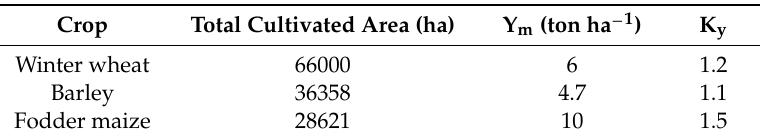
Higher K y numbers indicate higher sensitivity of the crop to water stress.